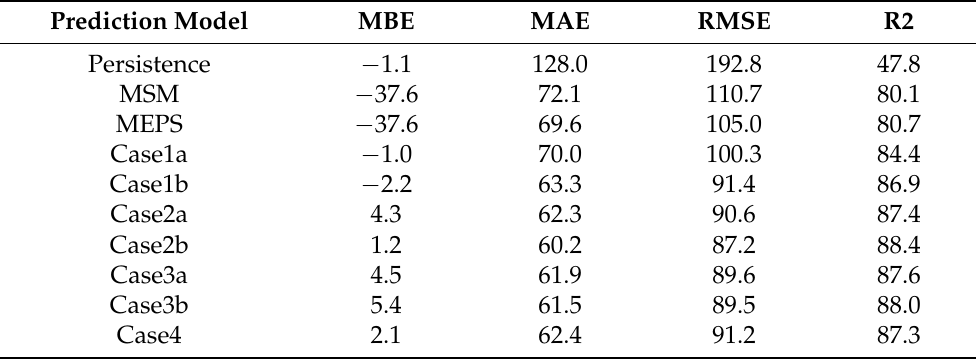
Table 2. Evaluation score of the prediction models. MBE, MAE, and RMSE are in W · m − 2 . R2 is in